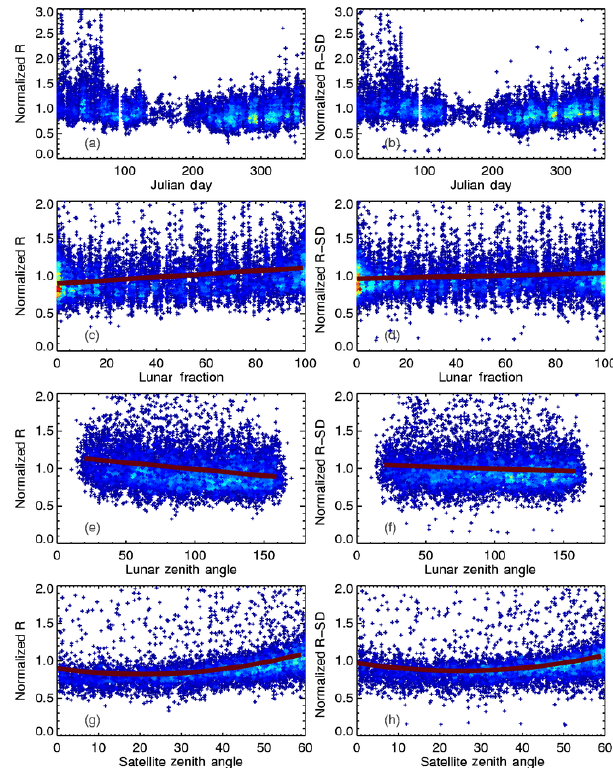
Figure 4. Panels (a) , (c) , (e) and (g) show the normalized radiance of artificial light sources (200 selected cities over the US for 2015) as functions of Julian day, lunar fraction, lunar zenith angle and satellite zenith angle, respectively. Panels (b) , (d) , (f) and (h) show similar plots as those in panels (a) , (c) , (e) and (g) but for the nor- malized standard deviation of radiance for artificial light sources. Cold to warm colors represent data density from low to